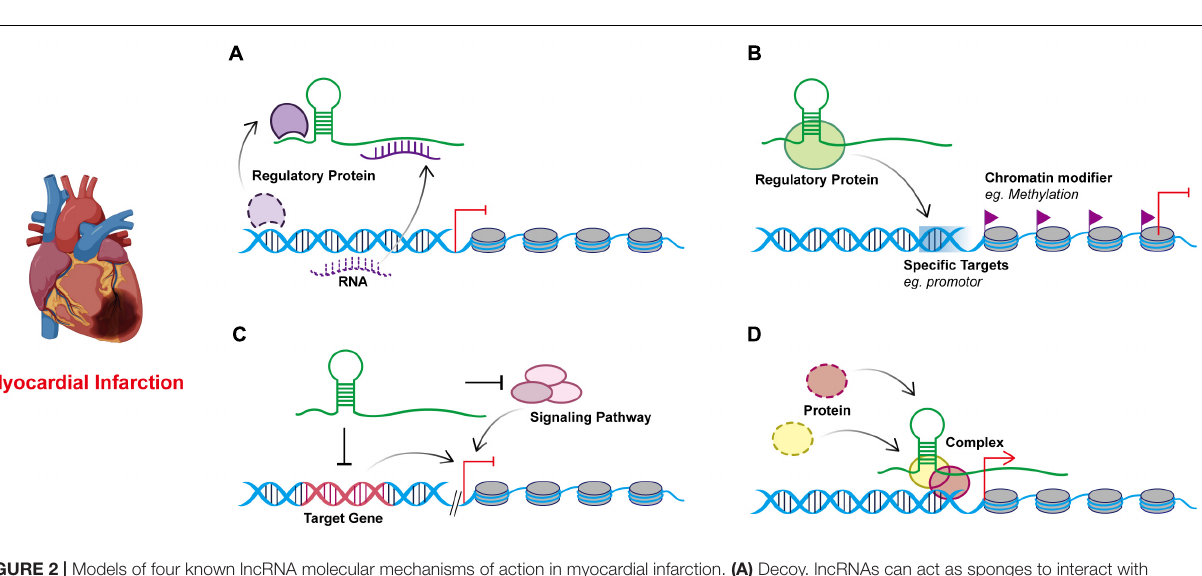
FIGURE 1 | Schematic diagram of representative lncRNA categories. Based on the location of lncRNAs relative to adjacent protein-coding genes, lncRNAs can be classified as: (A) Sense. Transcribed from the sense strand of protein-coding genes, can be considered as transcription variants of protein-coding mRNAs, which usually overlap exons by sharing the same promoter (Ma et al., 2013). (B) Antisense. Transcribed from the antisense strand of protein-coding genes, overlapping with protein-coding genes or covering the entire protein-coding sequence through intron. (C) Intergenic. Also known as long intergenic non-coding RNAs (lincRNAs), transcribed between two protein-coding genes, and located distant from other genes (Schmitz et al., 2016). (D) Intronic. Transcribed from introns of protein-coding genes in either sense or antisense orientation. (E) Bidirectional. Transcribed in the opposite direction of the protein-coding gene promotor within 1 kb.